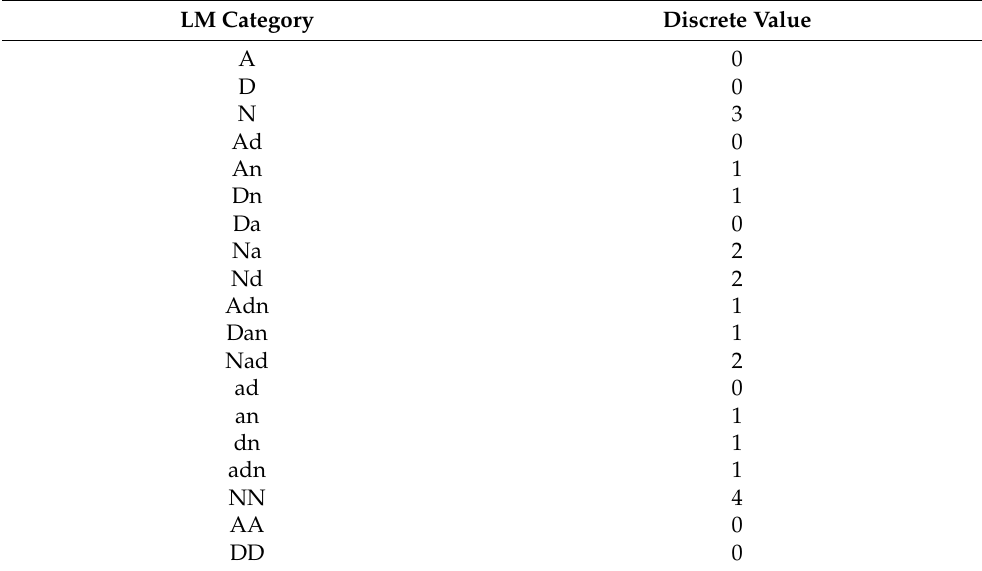
Table 2. Values assigned to each LM